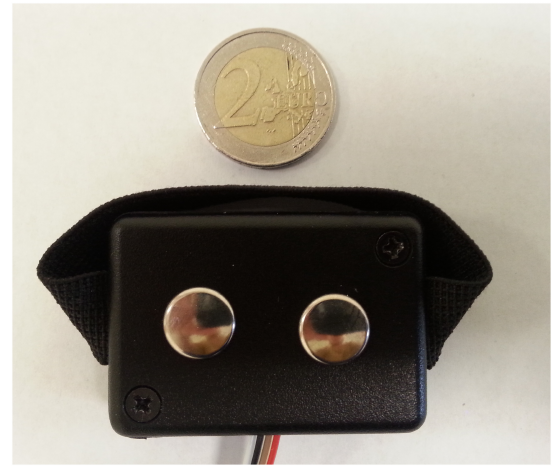
Fig. 5. Skin conductance